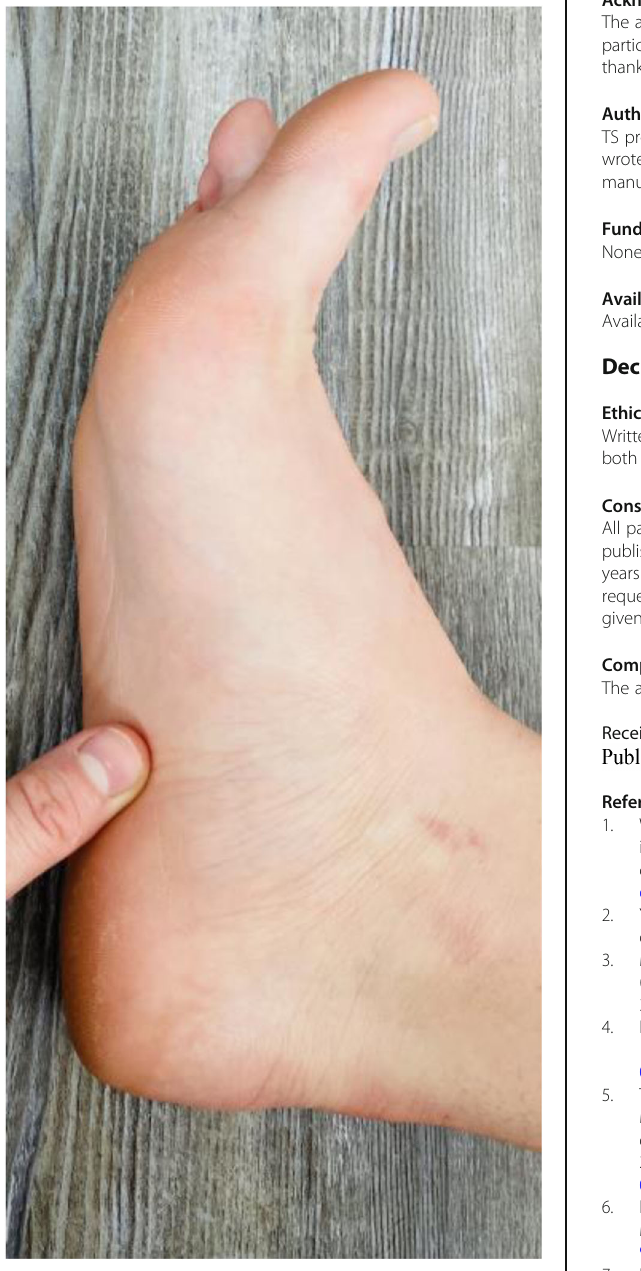
Fig. 3 Soft tissue mobilizations to the plantar fascia and lateral plantar nerve. Pictures taken with written and verbal